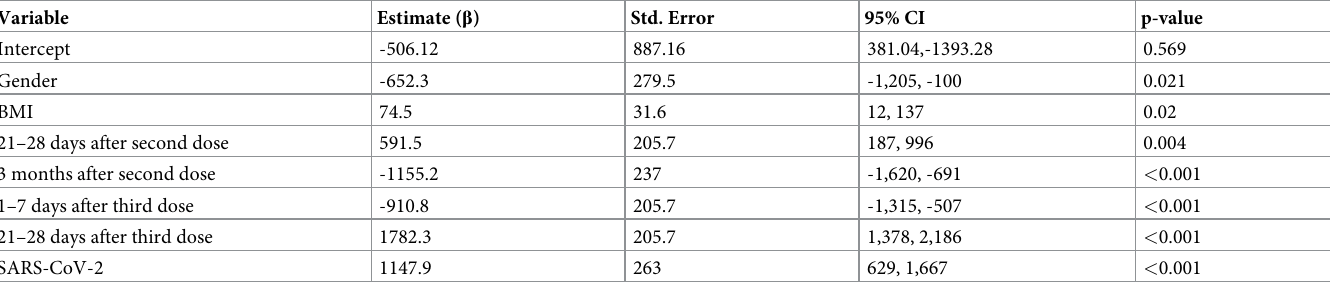
Mixed model in which the dependent variable was the quantitative SARS-CoV-2 spike 1–2 IgG antibody titers. Antibodies determined 21–28 days after the first BNT126b2 were the reference group. AIC: